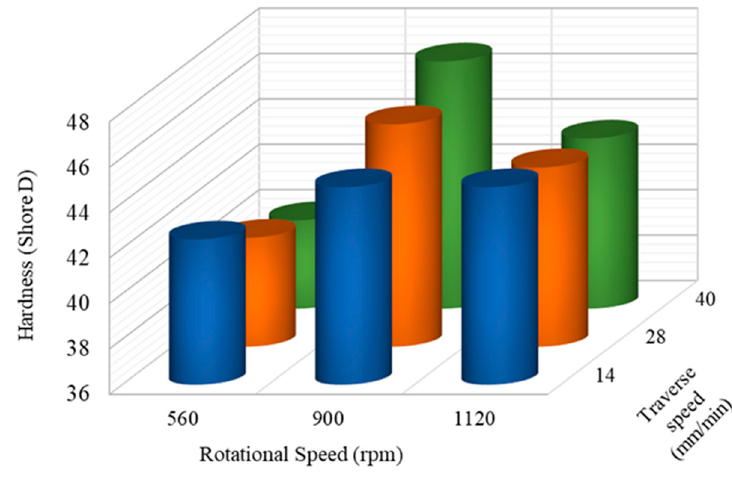
Figure 5. Influence of process parameters on the hardness of joints.